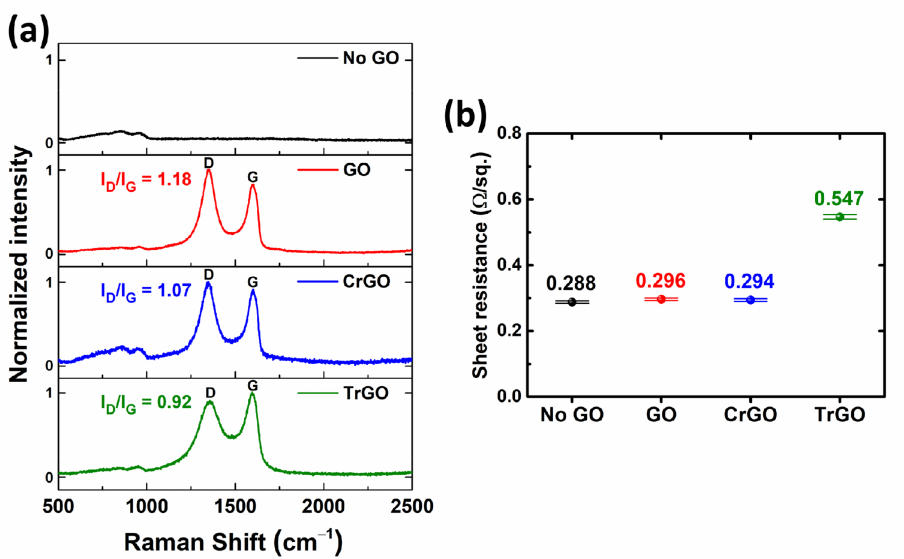
Figure 3. ( a ) Raman spectra and ( b ) sheet resistances of the various graphene oxide intermediate layers on the Mo back contact.